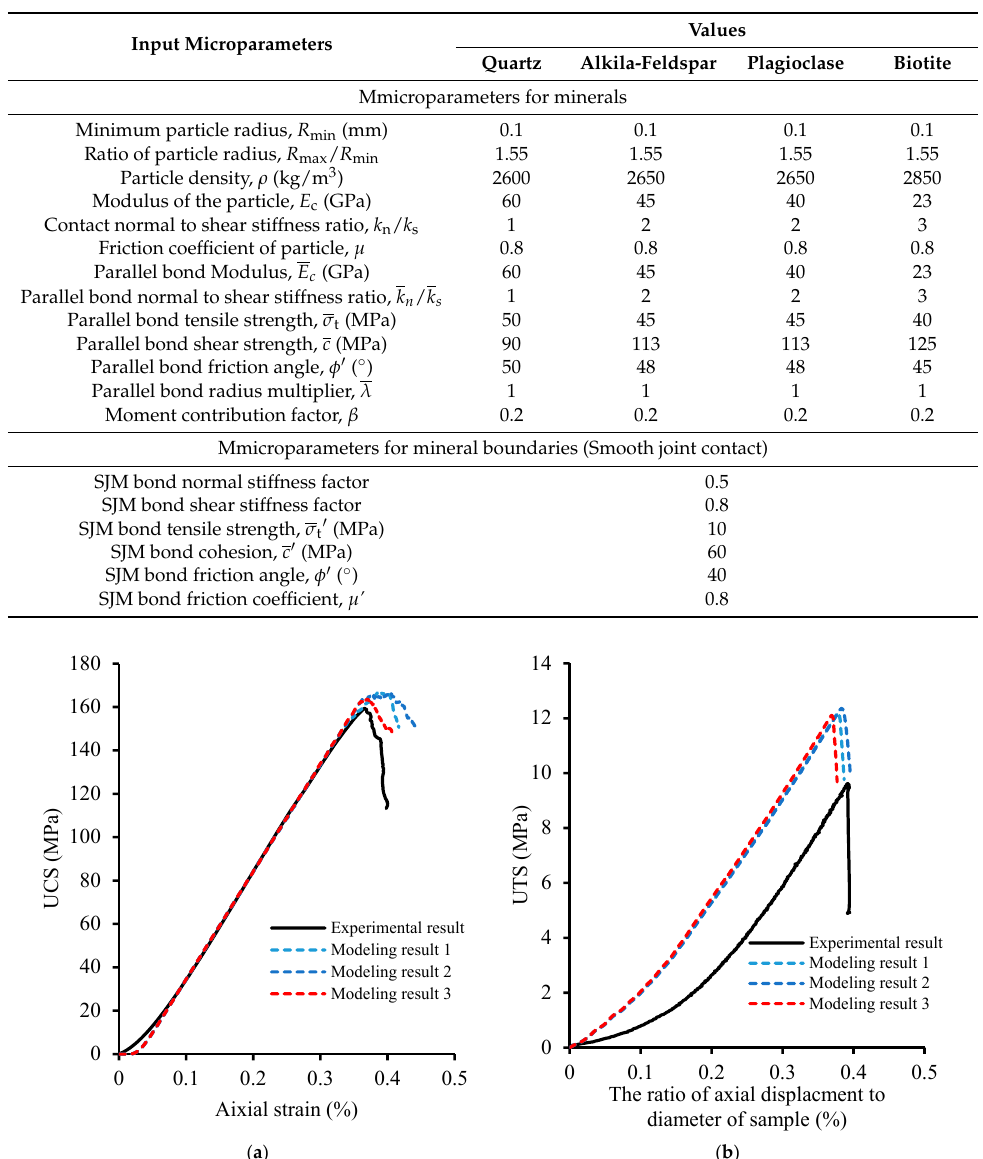
Table 1. Input microscale parameters for modeling of cement mortar and natural fractures.